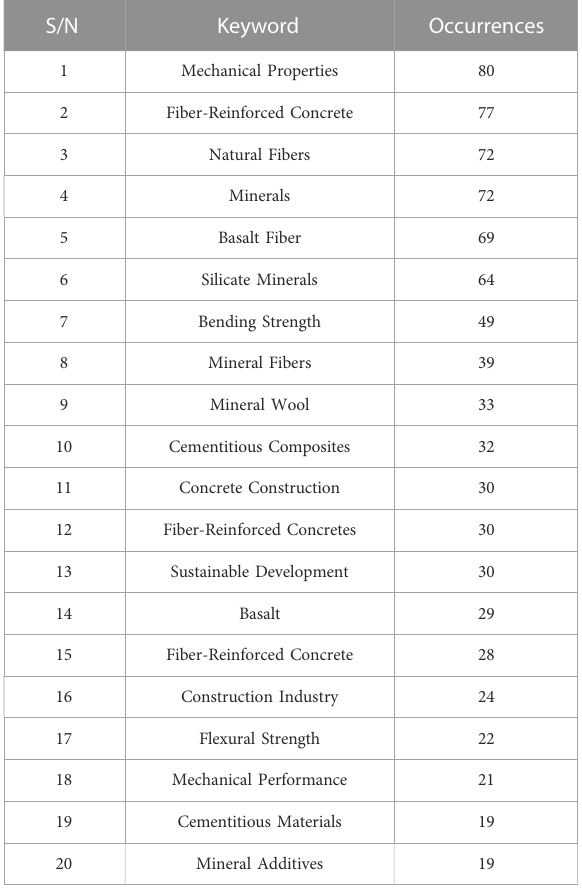
TABLE 2 List of the top twenty most-used keywords in the research of mineral fi ber-reinforced concrete.